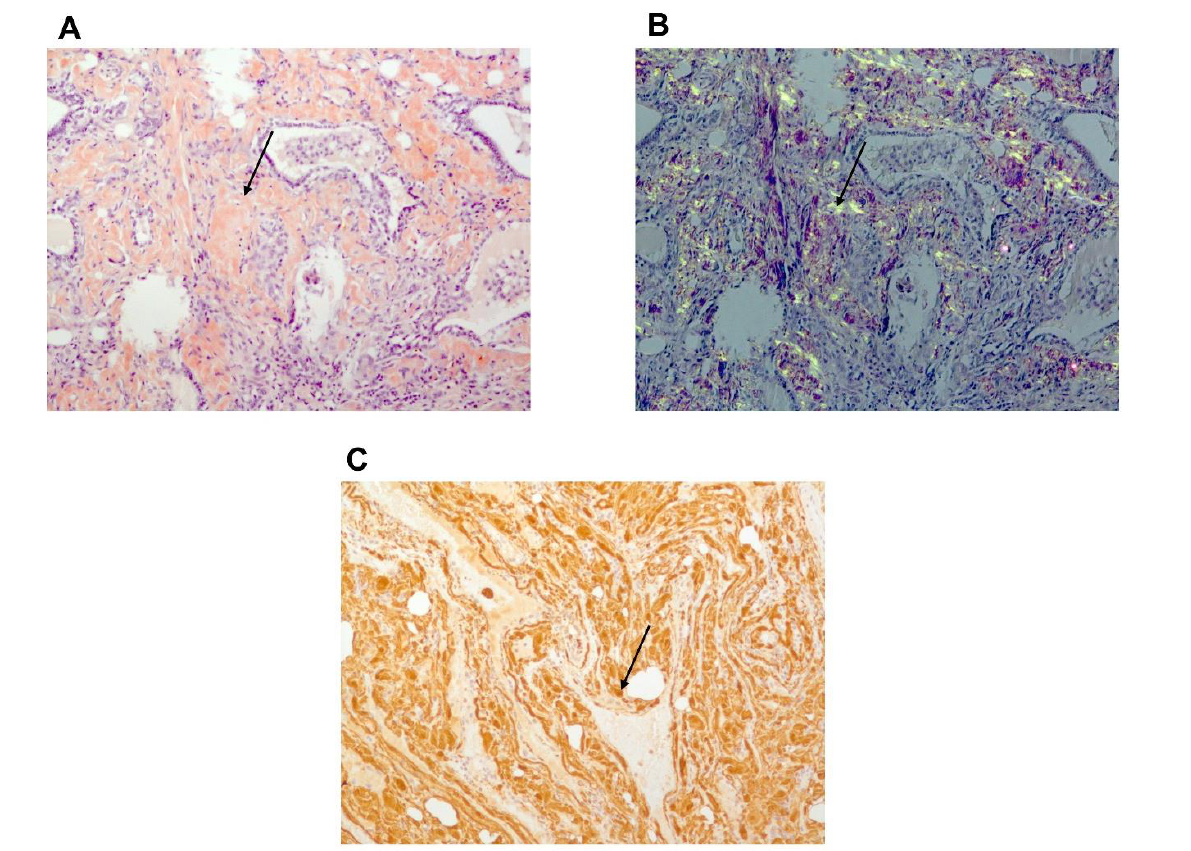
Figure 6. Histology: thyroid pathologic sample of patient B with amyloid deposits. ( A ) Congo red staining showing amyloid deposits. ( B ) Typical yellow-green bi-refringence of amyloid deposits under polarized light showing amyloid deposits. ( C ) Immuno-histochemistry. Brown staining due to strong fixation of anti-SAA antibody by amyloid deposits. Black narrow indicates amyloid deposit.